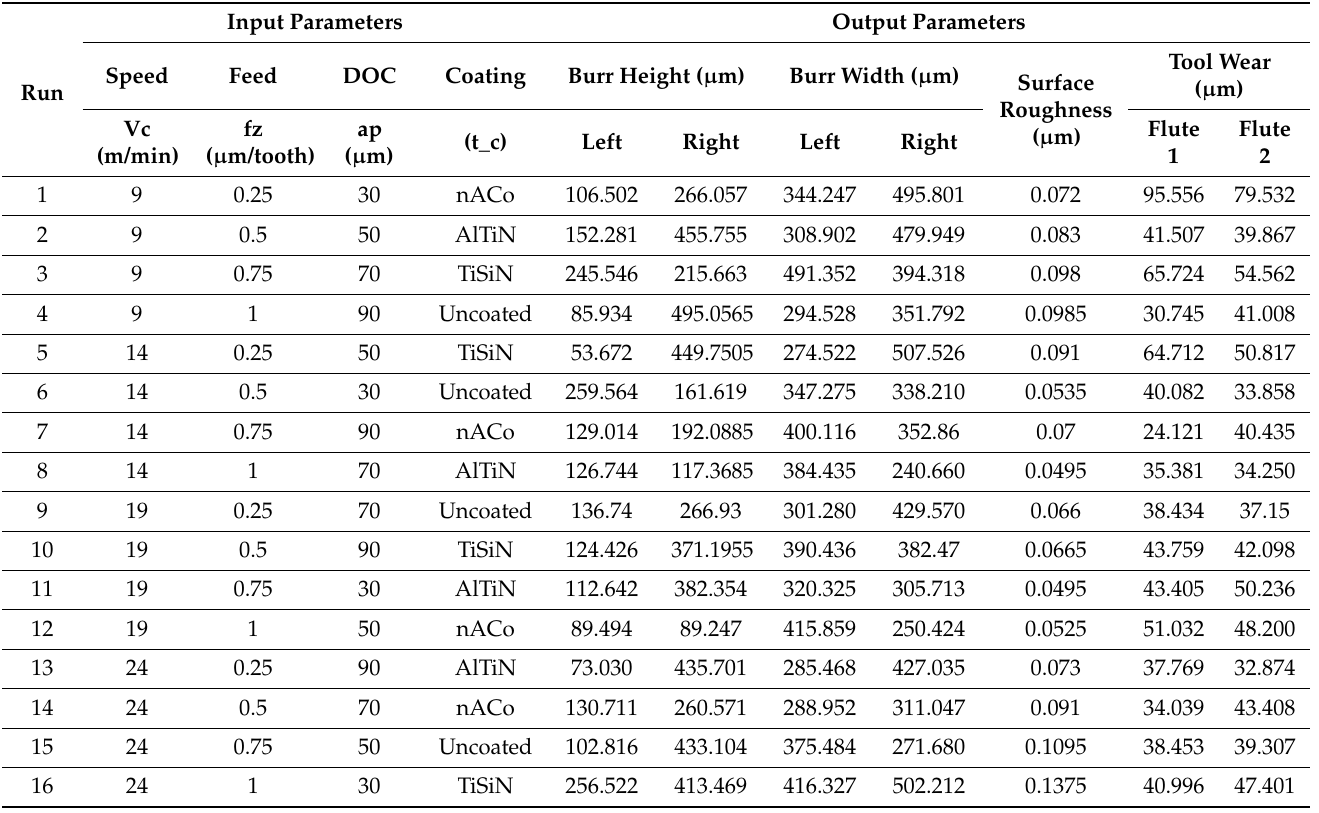
Table 3. Experimental design (Taguchi L16 array) with resulting burr formation, surface roughness, tool